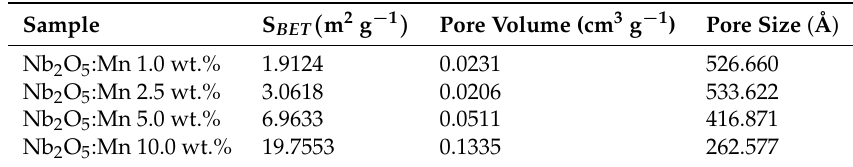
Table 2. Results of N 2 physisorption analysis on samples subjected to 700 ◦ C The specific surface